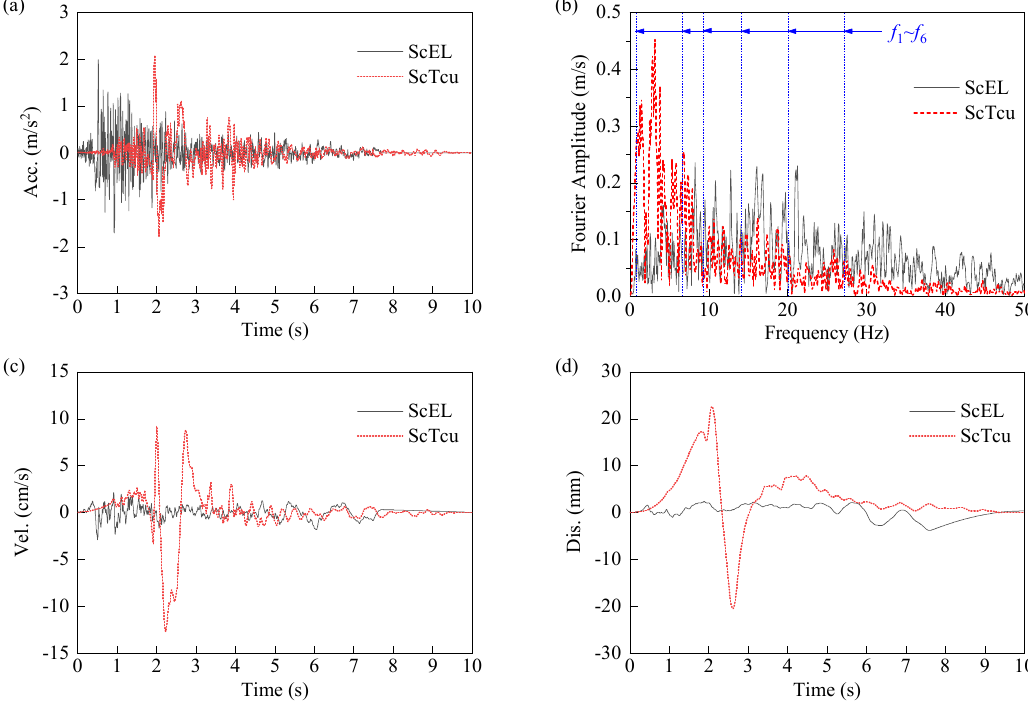
Figure 9. Input ground motions ( a ) Acceleration time histories; ( b ) Acceleration Fourier Amplitude; ( c ) Velocity time histories; ( d ) Displacement time histories;